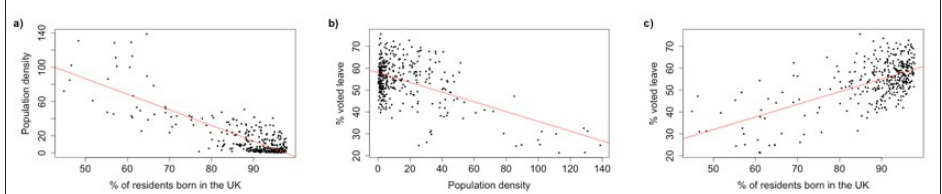
Figure 2: Graphs showing the relationship between a) population density and percentage of residents born in the UK, b) percentage of people who voted leave and population density, and c) the percentage of people who voted leave and percentage of residents born in the UK (by local